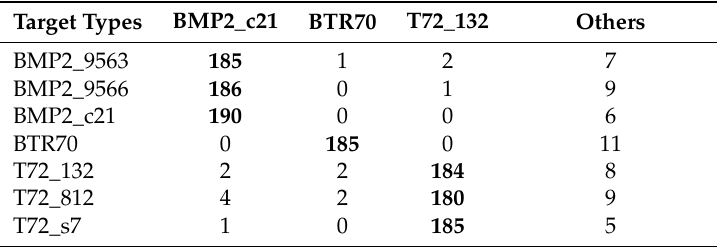
185 5 The number of the “in-targets” HRRP sequences in the test set =